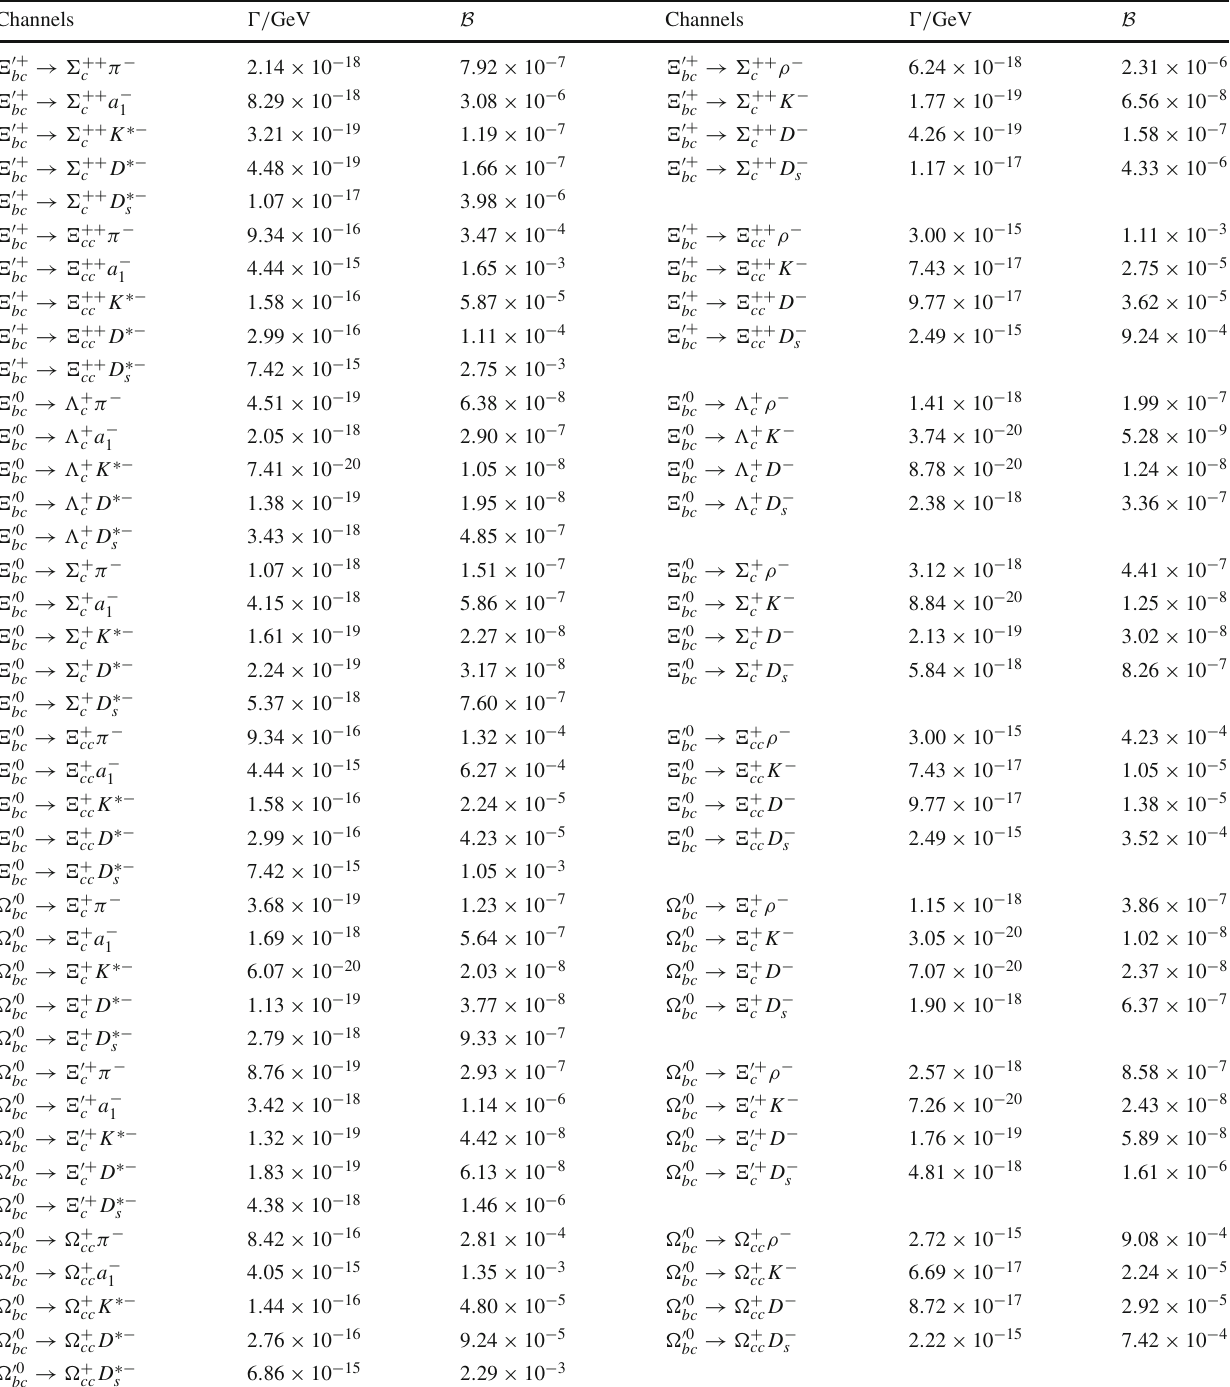
Table 29 Partial decay widths and branching ratios for nonleptonic decays: the bc sector with the b quark decay and a scalar bc diquark in the initial state. We have assumed